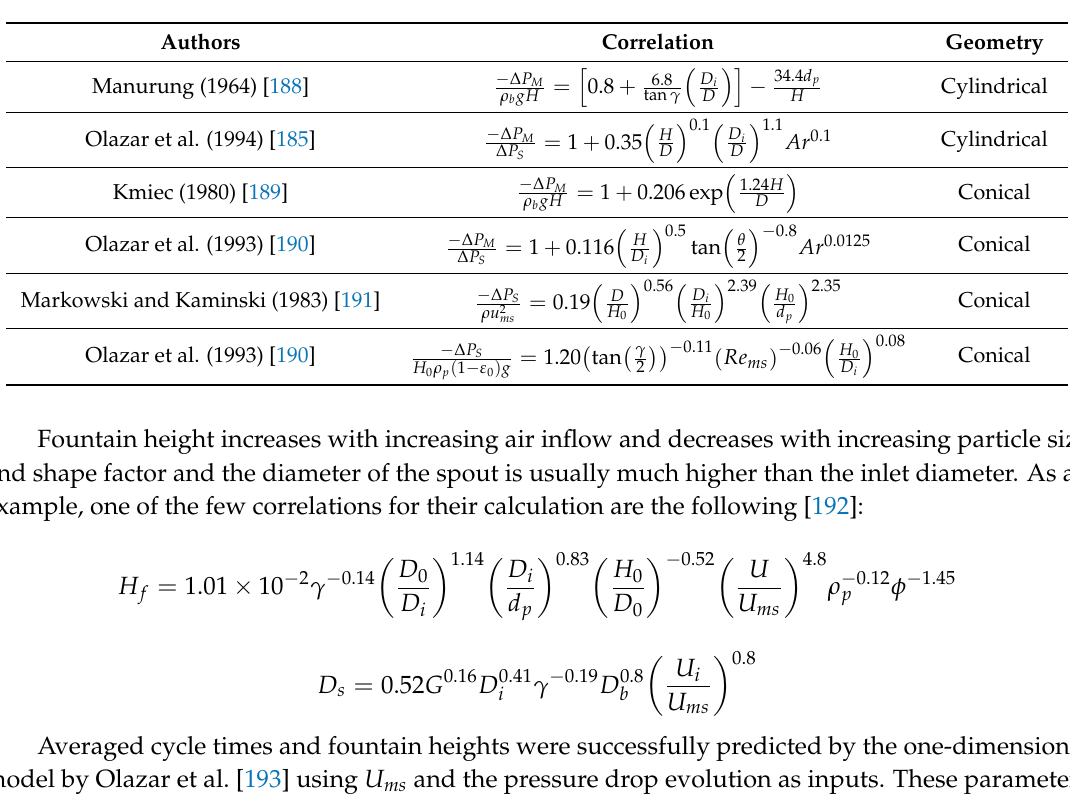
Table 6. Most applied correlations for ∆ P M and ∆ P S